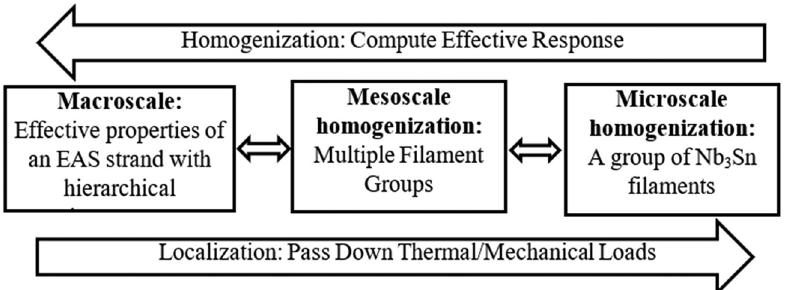
Figure 4: Date fl ow of multiscale homogenization and location of hierarchical microstructures of Nb 3 Sn